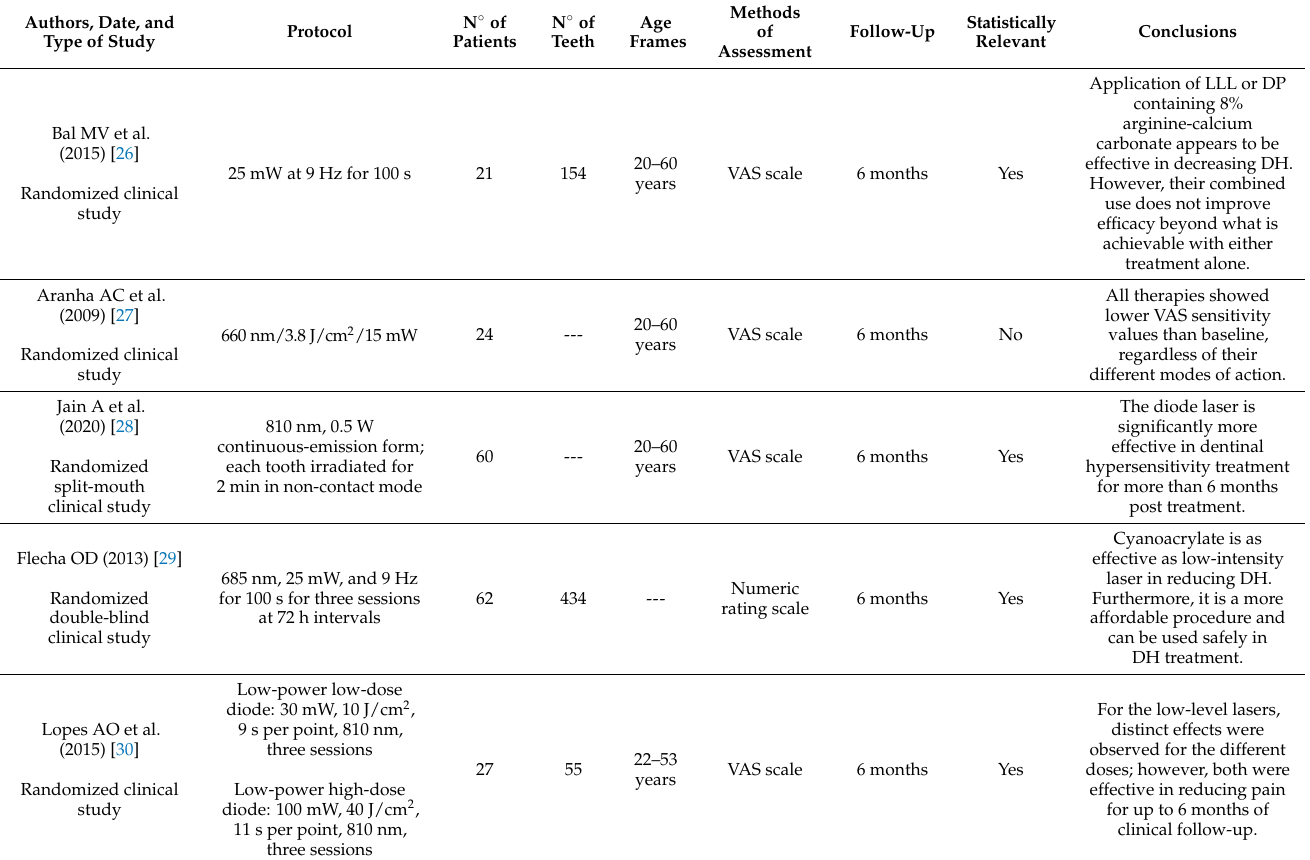
Table 2. Characteristics of the included studies on the use of low-power diode lasers in dentinal hypersensitivity